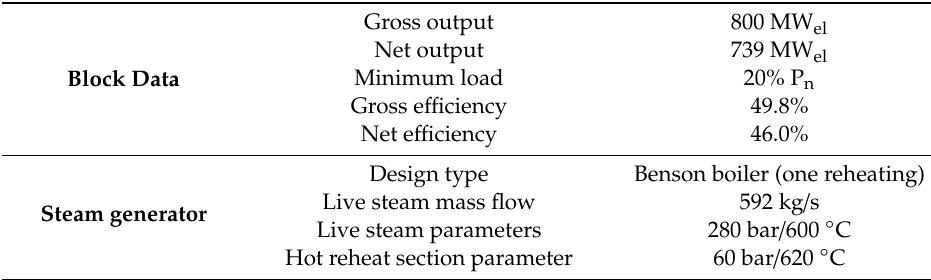
Table 1. Process parameters of the stationary power plant